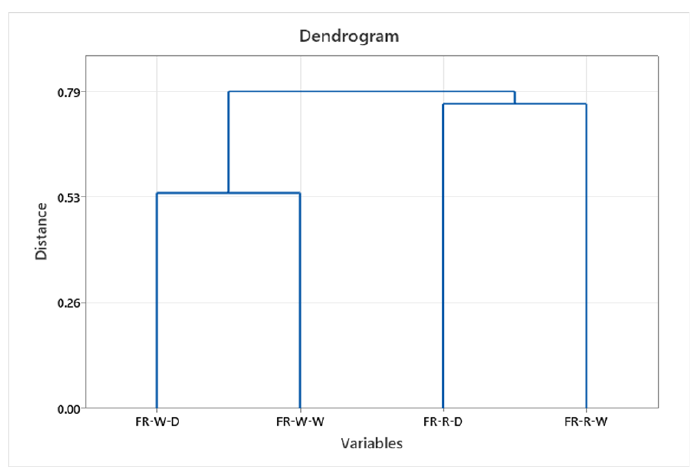
Figure 11. HCA dendrogram of the Py-GC/MS dataset for FRs.